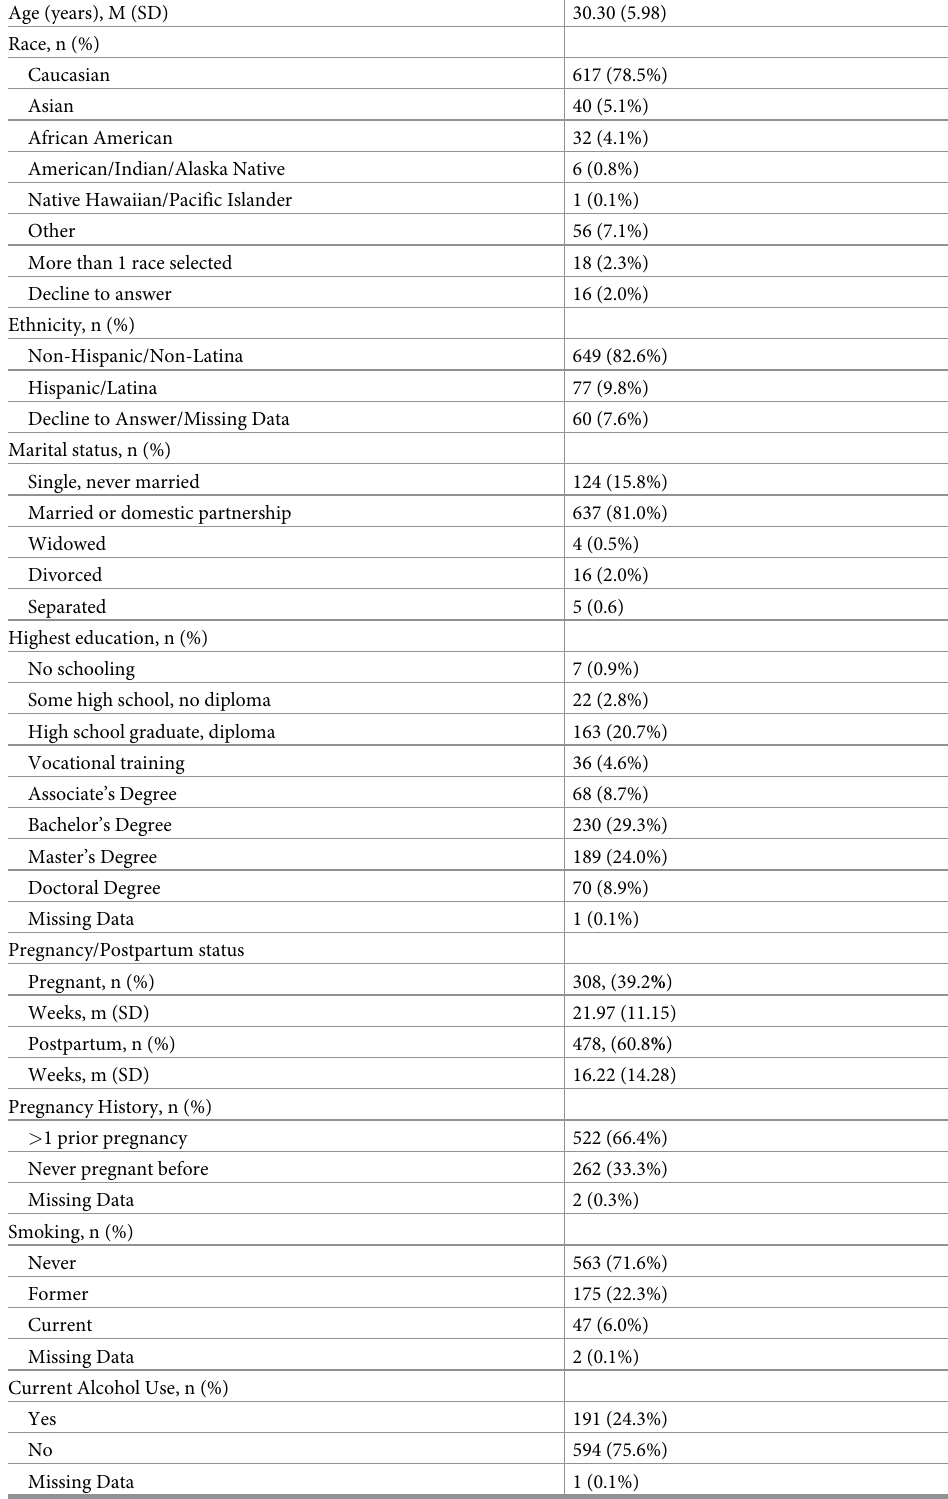
Table 1. Sample demographics (N =